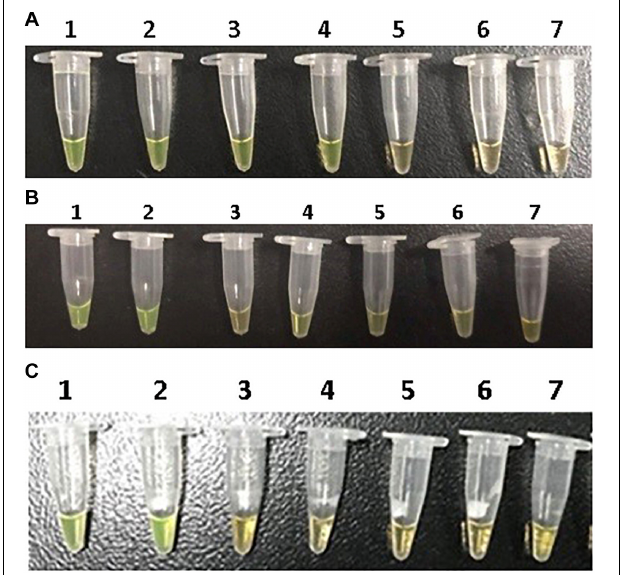
FIGURE 2 | Sensitivity of PMA-CPA assay for detection of VBNC cells of rfbE (A) , stx1 (B) , and stx2 (C) genes by mixed chromogenic agent in food samples. M-DNA marker; lanes 1–7, 10 6 , 10 5 , 10 4 , 10 3 , 10 2 , and 10 CFU/ml, negative